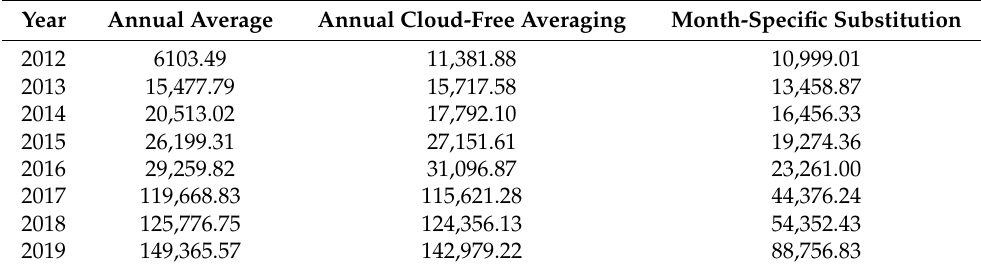
Table 4. Total night-light values of annual images obtained by different processing methods.